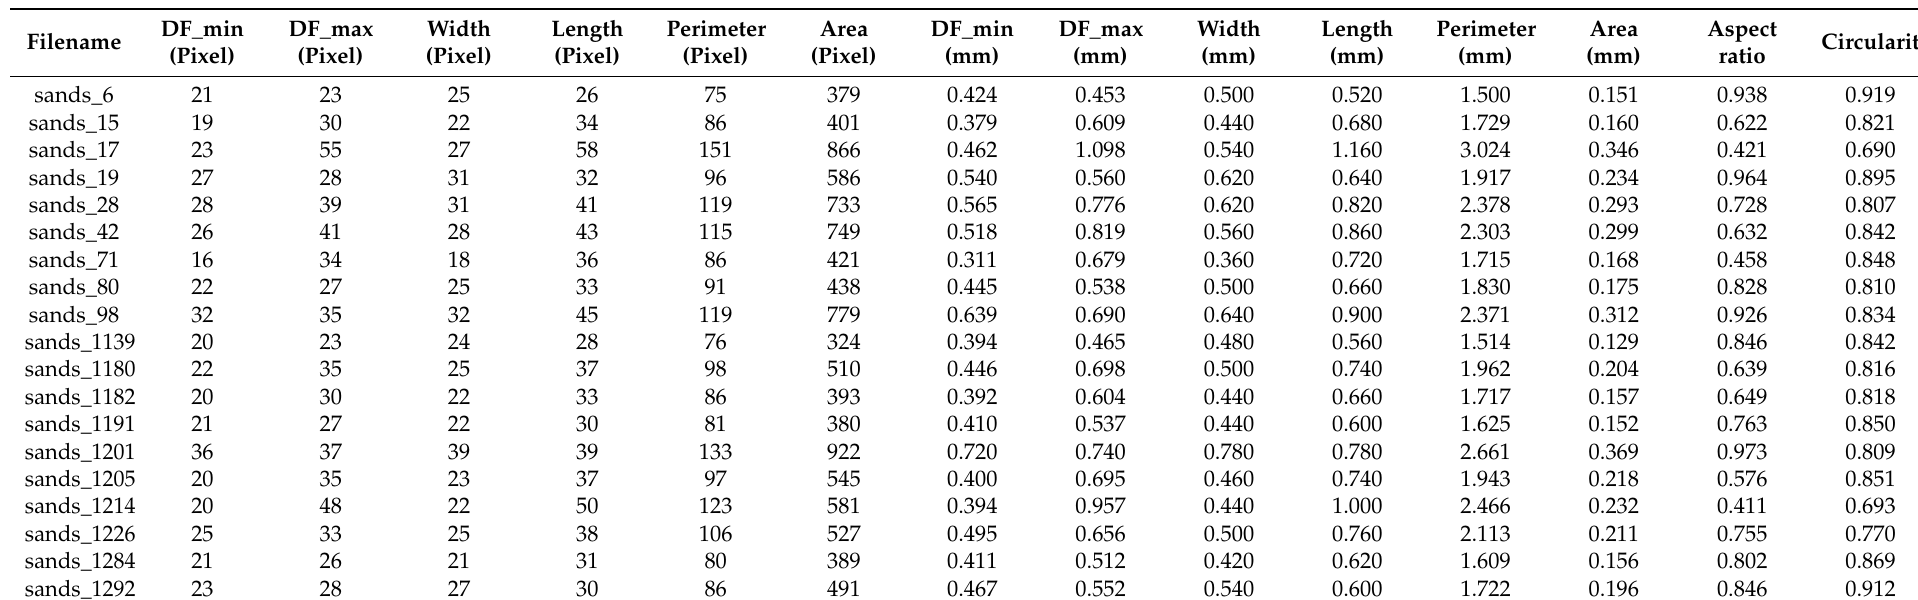
Table 3. The statistical results of morphologic parameters of 20 grains (the first 10 grains and the last 10 grains shown in Figure